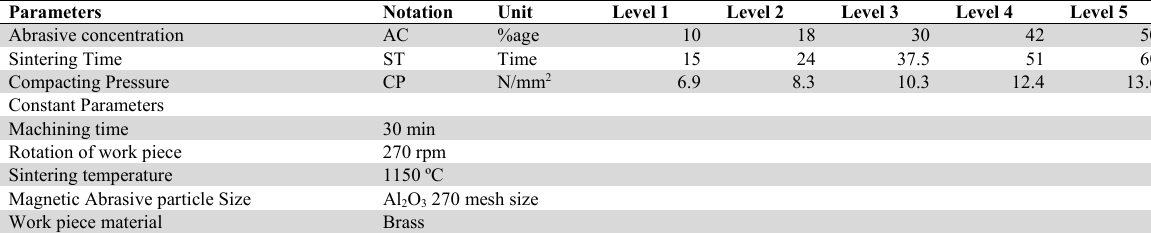
Input parameters and their levels